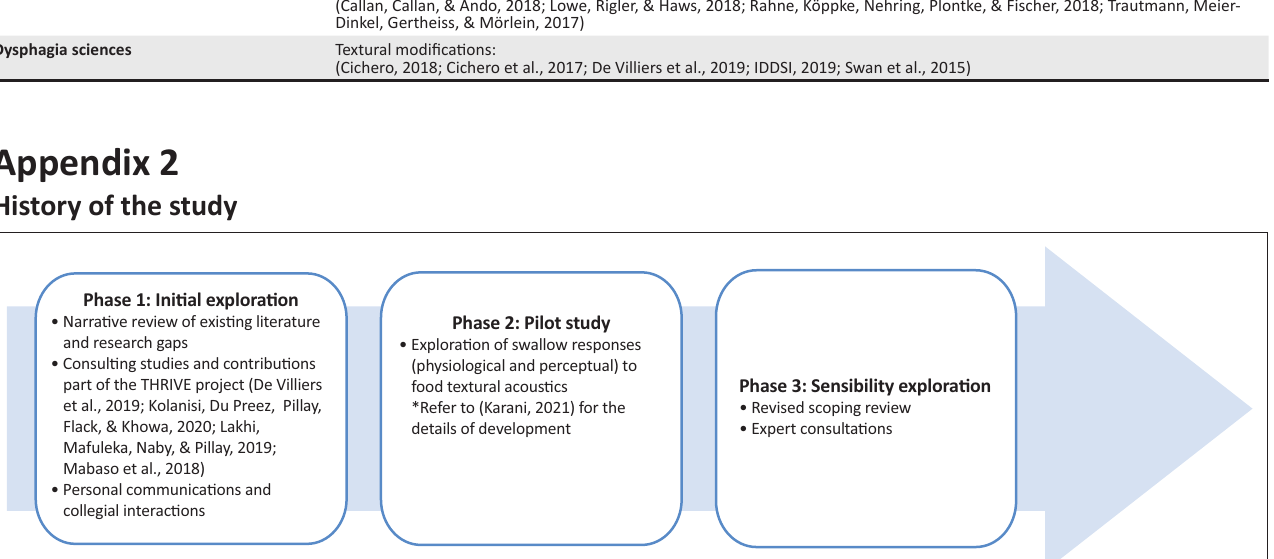
FIGURE 1-A2: The broader study involved three main phases (initial exploration, pilot study and sensibility exploration). Phase 3 formed the primary focus of this article.